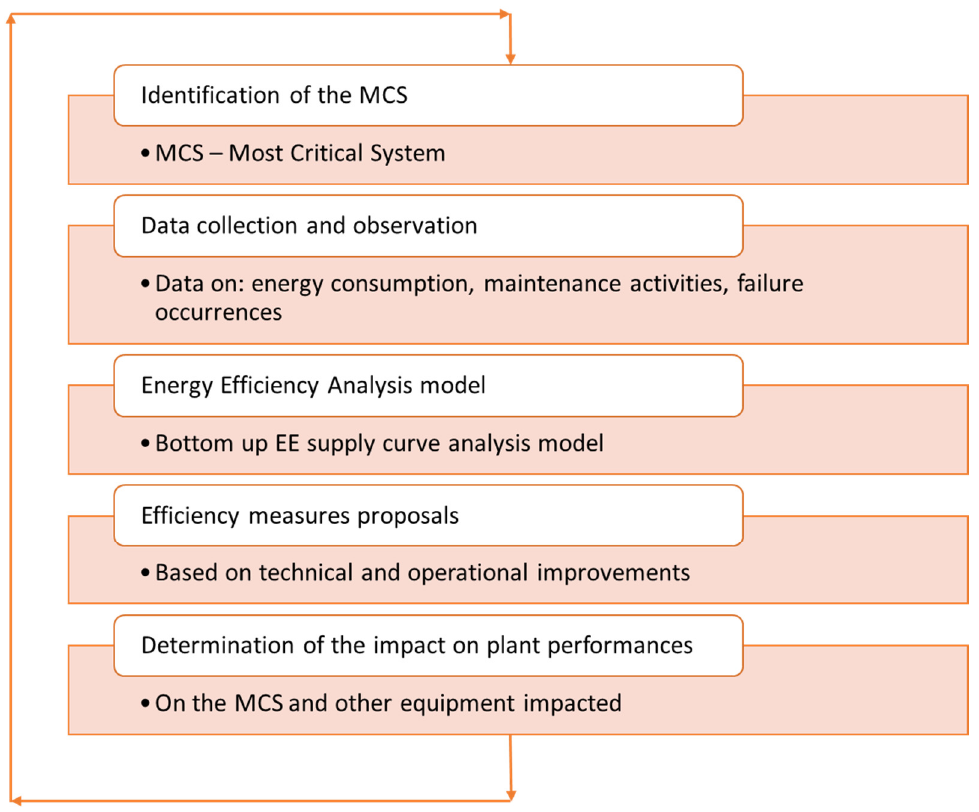
Figure 1. Scheme of the adopted framework.